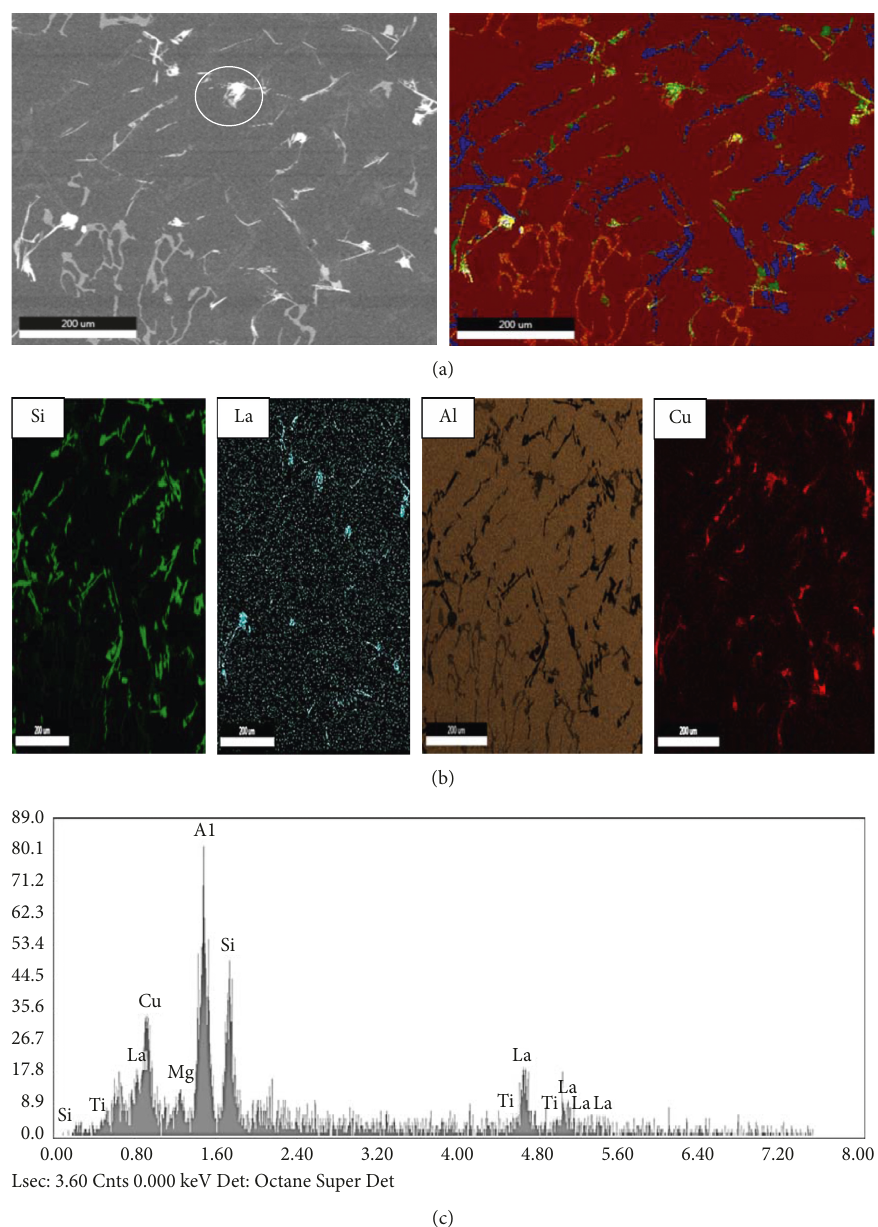
Figure 14: La–Cu interactions in D0 +La alloy: (a) backscattered image, (b) corresponding X-ray images of Si, La, Al, and Cu, and (c) EDS spectrum of white phase circled in